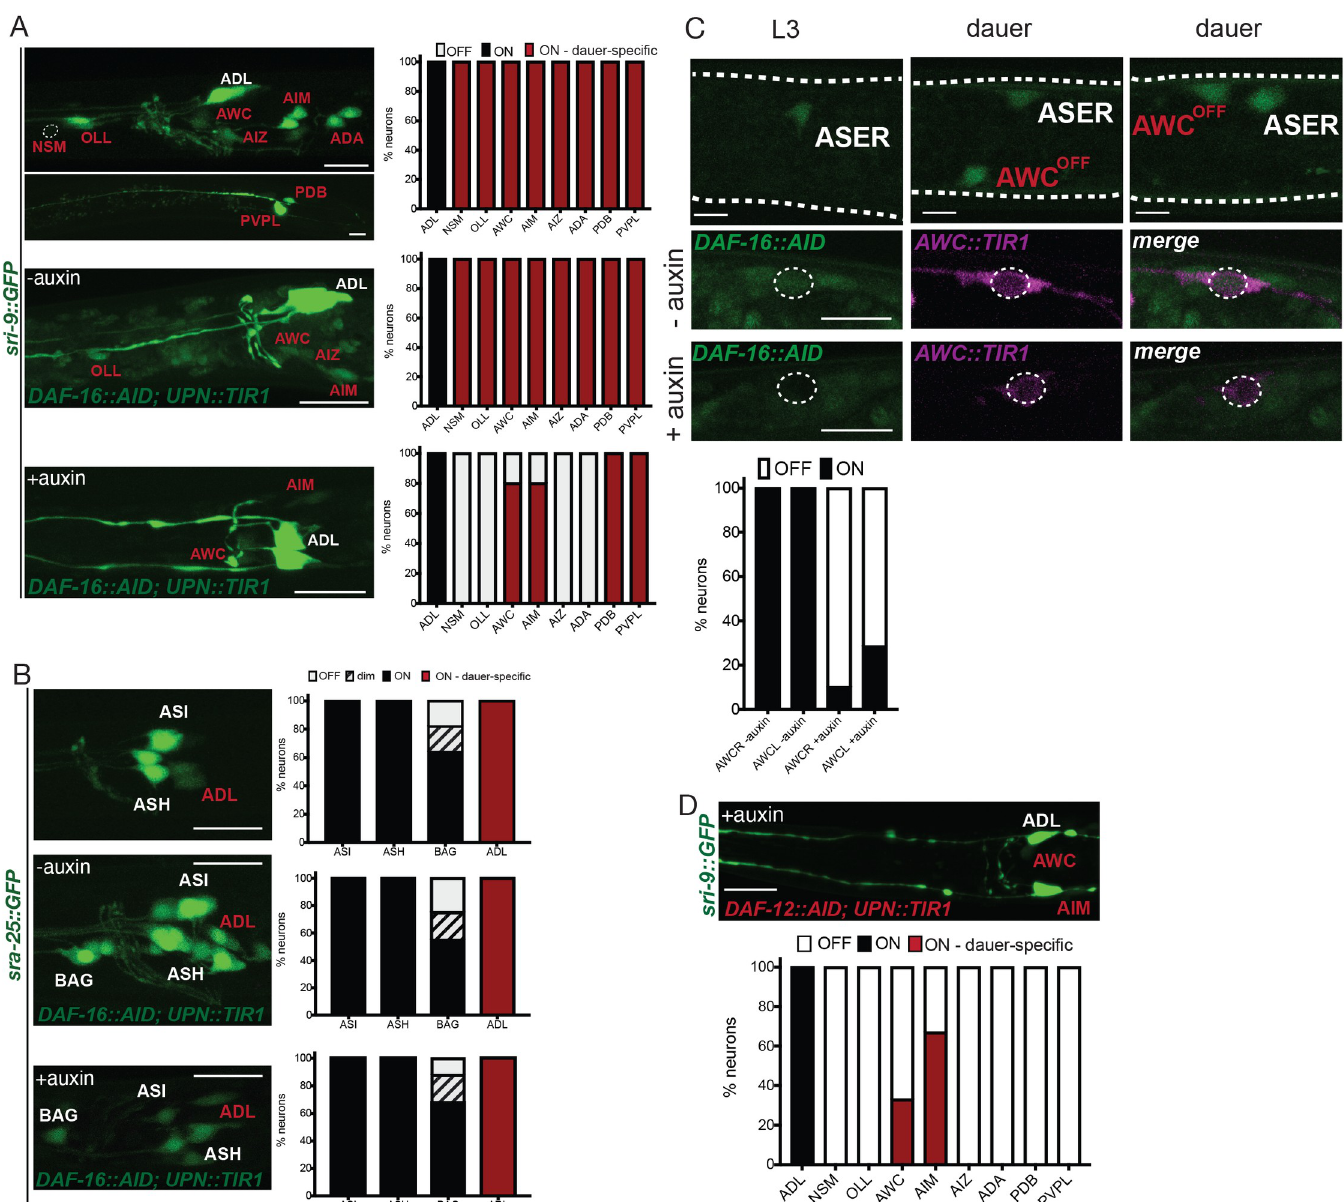
Fig 5. Neuronal removal of DAF-16/FoxO and DAF-12/VDR affects dauer-specific sensory receptor expression changes. ( A ) sri-9 :: GFP ( otIs732 ) expression induced in multiple neurons in dauer (red). The dauer-specific expression is largely dependent on the neuronal function of DAF-16/FoxO. Left, head images of control and auxin- treated dauers with panneuronal depletion of DAF-16/FoxO. Right, quantification of sri-9 :: GFP expression in each neuronal type. n = 22 (control) and n = 10 (auxin treated). Scale bars, 10 μ m. ( B ) sra-25 :: GFP ( sIs12199 ) expression induced in ADL neurons in dauer (red). The dauer-specific expression is not dependent on neuronal function of DAF-16/FoxO. Left, head images of control and auxin-treated dauers with panneuronal depletion of DAF-16/FoxO. Right, quantification of sra-25 :: GFP expression. n = 22 (control) and n = 10 (auxin-treated). Scale bars, 10 μ m. ( C ) gcy-6 :: NLS :: GFP ( otIs586 ) expression is gained in AWC OFF neuron in dauer. Above, images of AWC in control and auxin-treated dauers with panneuronal depletion of DAF-16/FoxO. Below, quantification of gcy-6 :: NLS :: GFP expression. n = 12. Scale bars, 5 μ m. ( D ) The dauer-specific expression of sri-9 :: GFP ( otIs732 ) also depends on the neuronal function of DAF-12/VDR. Above, image of an auxin-treated dauer with panneuronal depletion of DAF-12/VDR. Below, quantification of sri-9 :: GFP expression in each neuronal type. Scale bar, 10 μ m. The data underlying this figure can be found in S1 Data. AID, auxin-inducible degron.